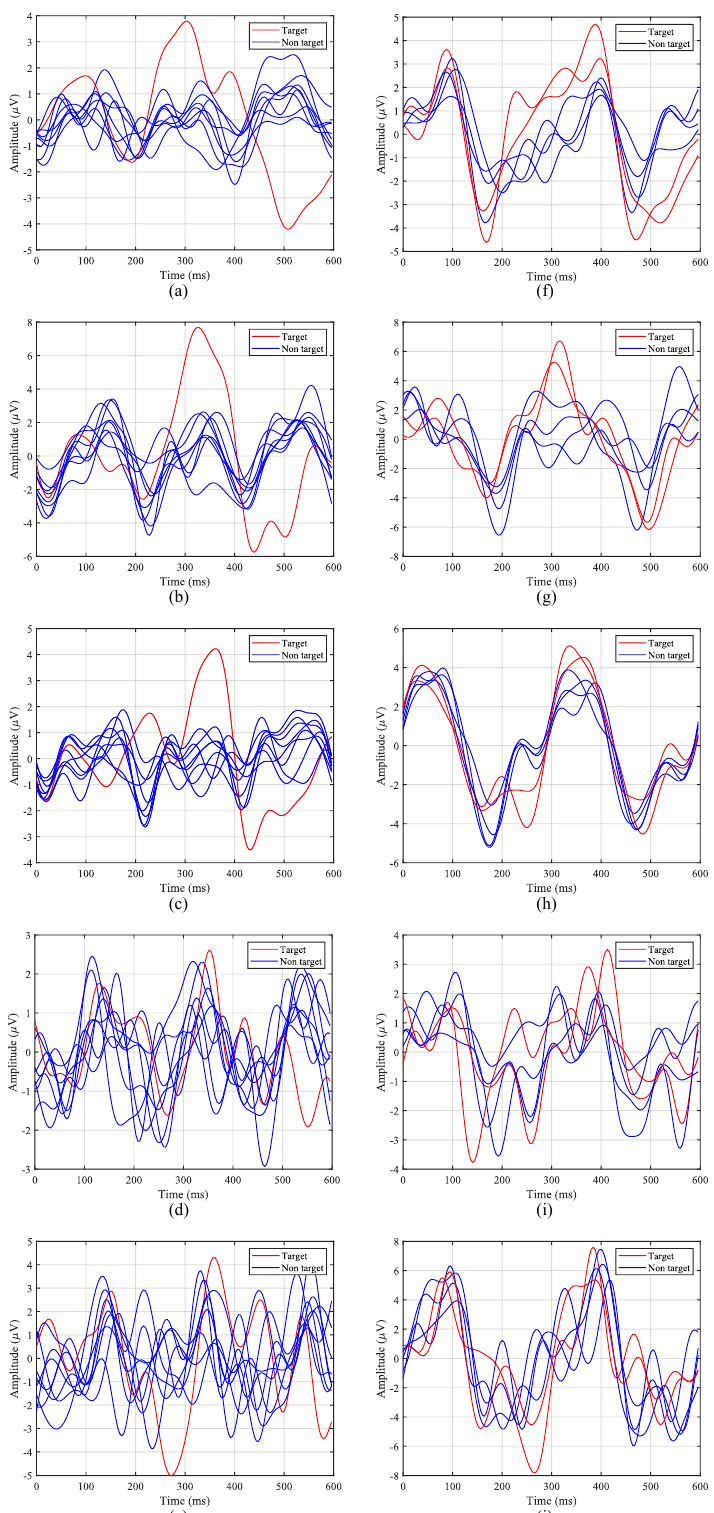
Figure 7. Averaged Event-Related Potentials (ERPs) from the first five participants for both stimula- tion paradigms: ( a – e ) 1-by-1 paradigm; ( f – j ) row/column